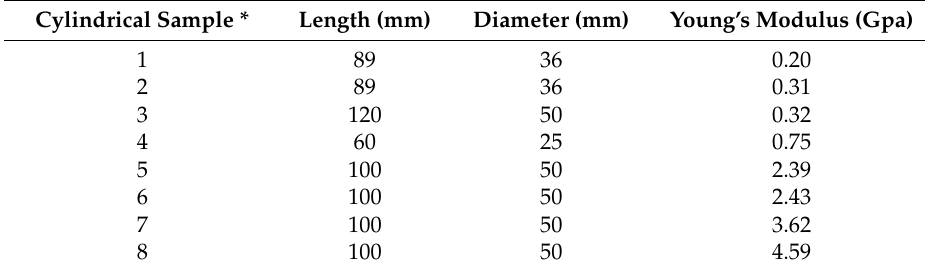
Table 5. Macroscale Young’s modulus of 3D printed gypsum samples by Uniaxial Compression Strength (UCS) and triaxial